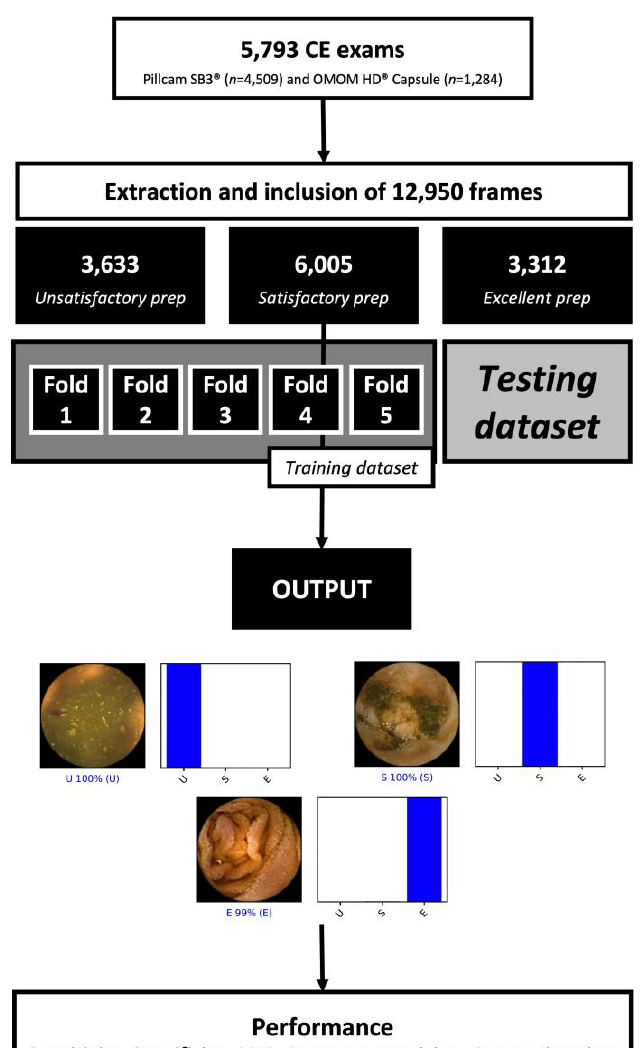
Figure 1. Flowchart indicating the procedures carried out in the training phase and the validation phase of the study, and indicating the proportion of the examinations carried out with each type of capsule. A five-fold cross validation examination was performed in the training stage. The level of cleanliness (Output) was classified as: Excellent, excellent bowel preparation (≥90% of the mucosa visualized); Satisfactory, satisfactory bowel preparation (50–90% of the mucosa visualized); Unsatisfactory, unsatisfactory bowel preparation (<50% of the mucosa visualized). Abbreviations: CE, Capsule Endoscopy; PPV, positive predictive value; NPV, negative predictive value; AUC; area under the ROC curve.